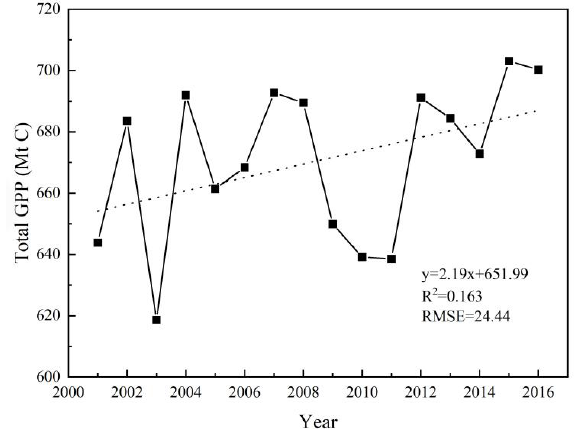
Figure 3 . The interannual variations in GPP from 2001 to